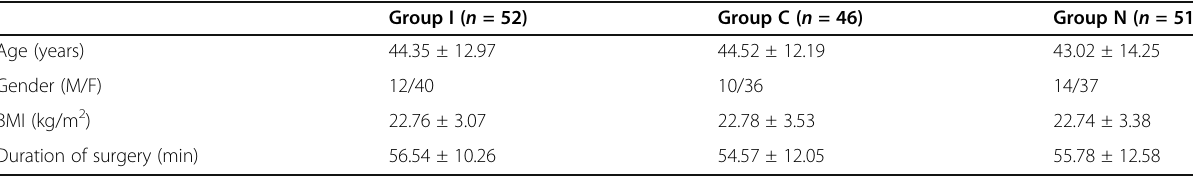
Table 1 Demographic profile and duration of surgery